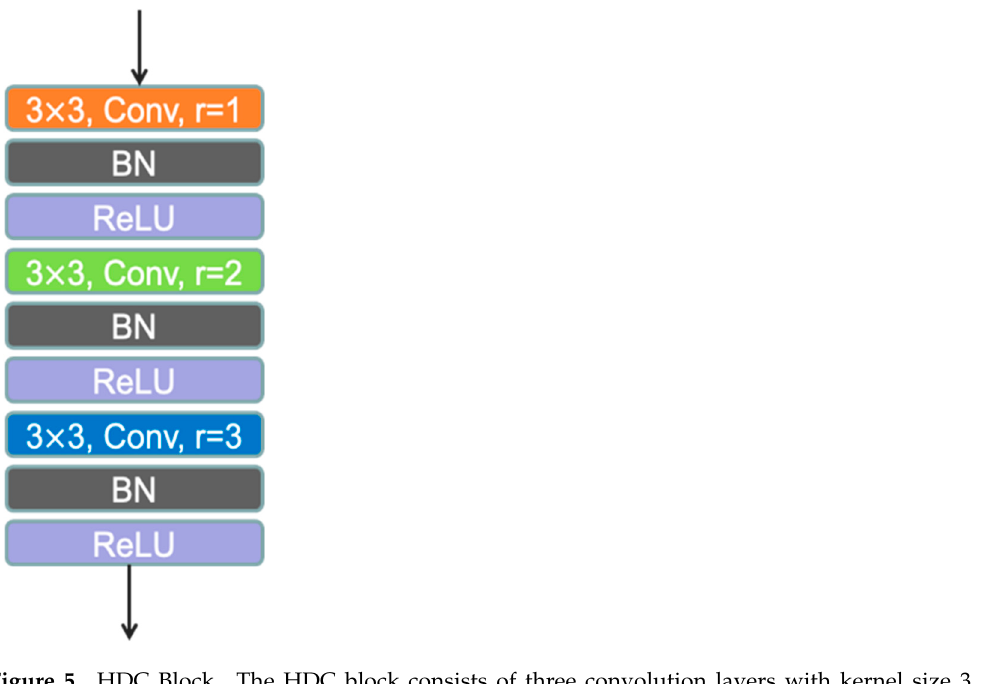
Figure 4. Different dilation rates of convolution layers. From left to right, r = 1, 2, 3, respectively.